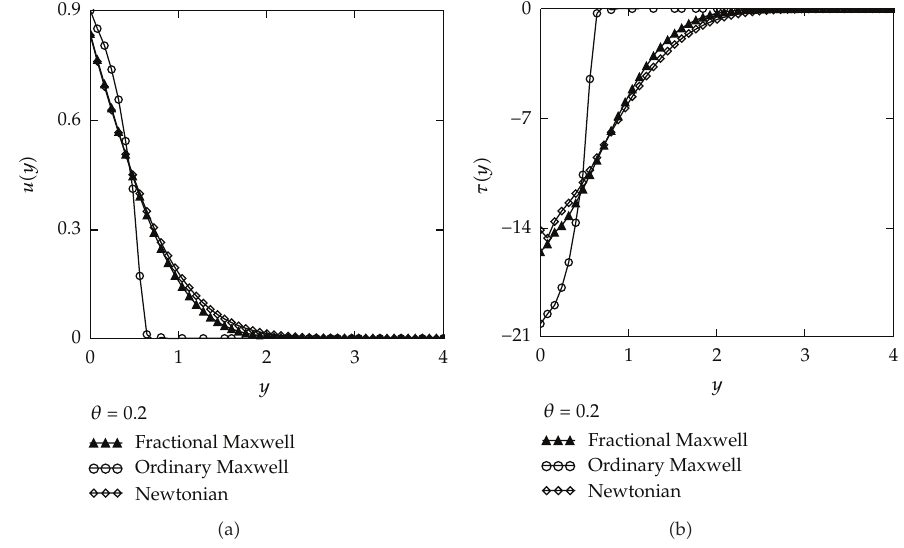
Figure 13: Profiles of the velocity field u (cid:4) y,t (cid:5) and the shear stress τ (cid:4) y,t (cid:5) for fractional Maxwell, ordinary Maxwell and Newtonian fluids, for U (cid:9) 1, y (cid:9) 1, ν (cid:9) 0 . 379, μ (cid:9) 33, λ (cid:9) 1 . 5, α (cid:9) 0 . 2, t (cid:9) 2s, and θ (cid:9) 0 .